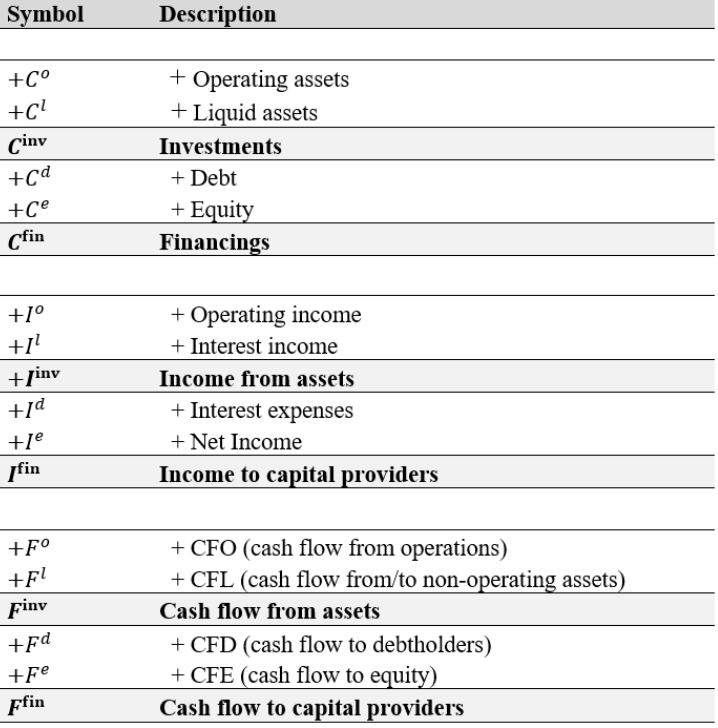
Figure 39. Structure of a column of the Transposed Matrix: capital amounts, incomes, and cash flows are in vertical format (symbol on the left, description on the right; see also Part I, Section 10.2). CODE INSTRUCTIONS: STRUCTURE OF TRANSPOSED MATRIX